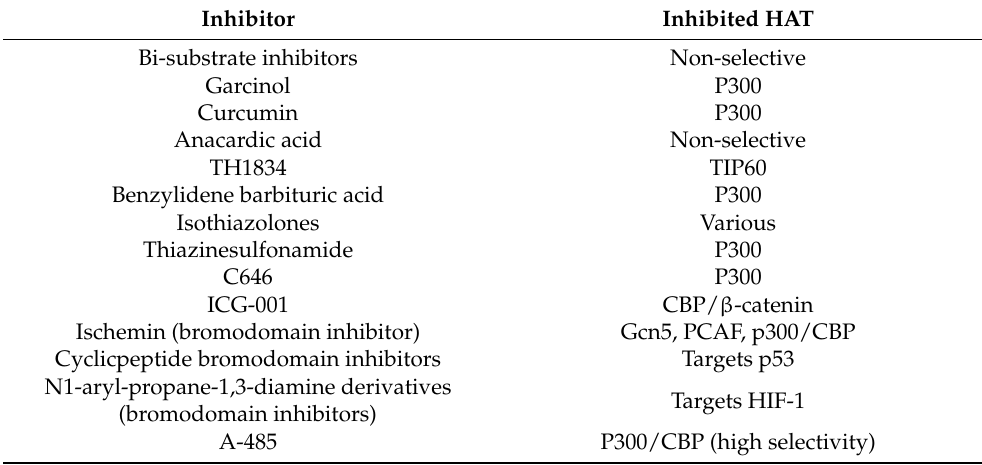
Table 2. Known HAT inhibitors